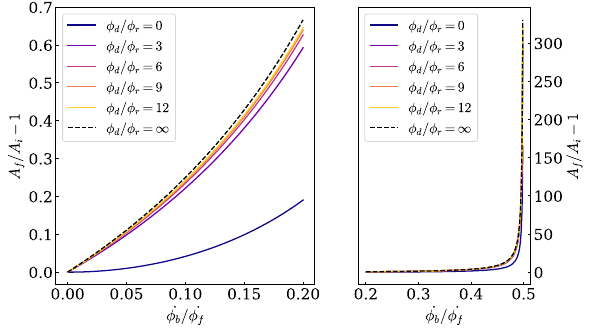
FIG. 4. Evolution of the bunch profile during fast expansion and compression at a normalized speed of oscillations after 60 ms are a clear indication for a nonadiabatic manipulation. Simulated (left) and measured (right) profiles are shown with their corresponding bunch